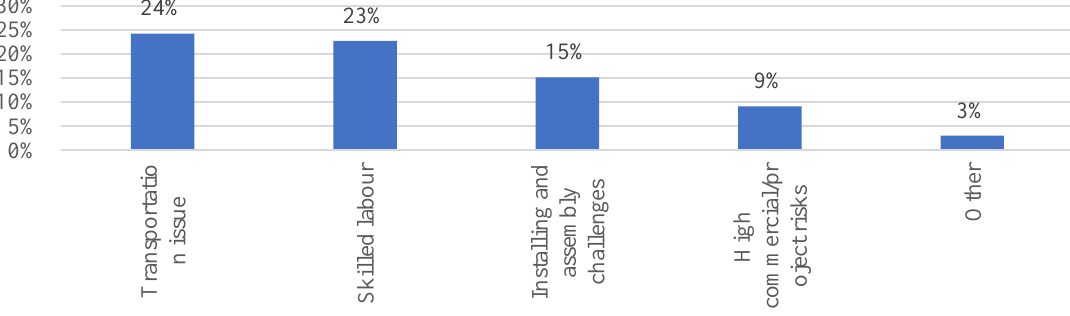
Figure 7. Project-level challenges of MTC.